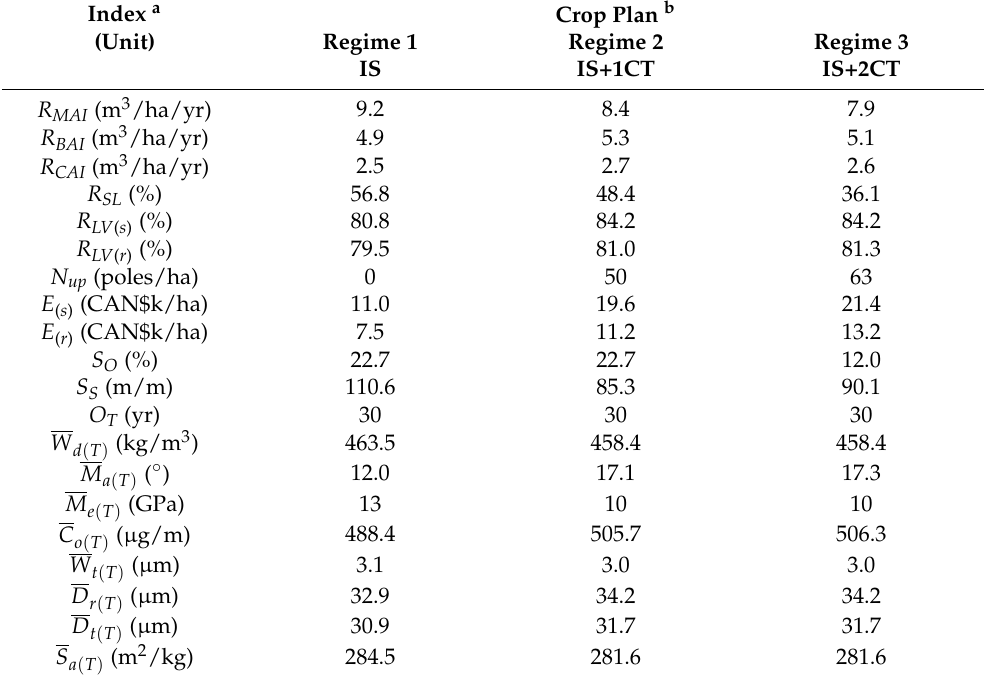
Table 2. SSDMM-derived rotational stand-level performance indices for 3 crop plans growing under a RCP8.5 for red pine plantations situated in north-central Ontario (Thessalon). Index a Crop Plan b (Unit) Regime